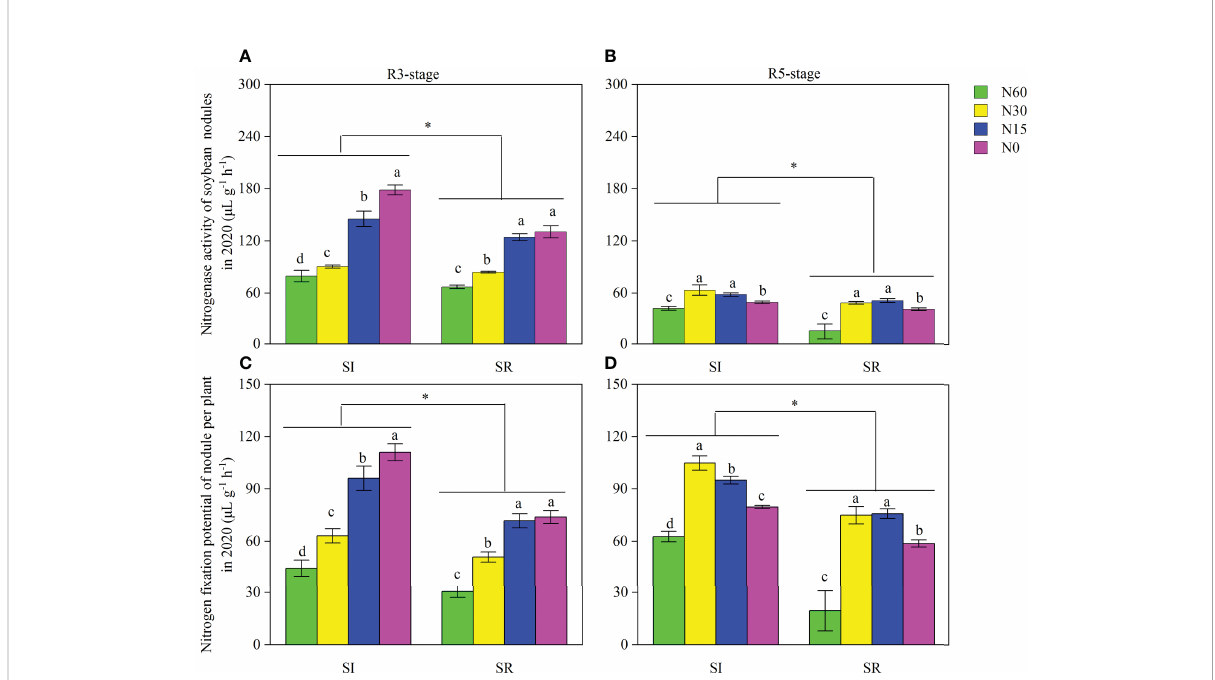
FIGURE 6 of straw incorporation and N application on nodule nitrogenase activity and nitrogenase fi xation potential of intercropped soybean at different growth stages (in 2020). Different lower-case letters indicate signi fi cant differences under different N application rates (LSD, P < 0.05). The asterisk “ * ” indicate signi fi cant differences ( P < 0.05) between straw incorporation and straw removal. Data were shown as mean ± S.D. (n=3). SI, straw incorporation; SR, straw removal; N60, convention N (60 kg N ha -1 ); N30, reduced N by 50% (30 kg N ha -1 ); N15, reduced N by 75% (15 kg N ha -1 ); N0, zero N (0 kg N ha -1 ); R3, the beginning pod stage of soybean; R5, the beginning seed stage of soybean. (A) , nitrogenase activity of soybean nodules at the R3 stage in 2020; (B) , nitrogenase activity of soybean nodules at the R5 stage in 2020; (C) , nitrogen fi xation potential